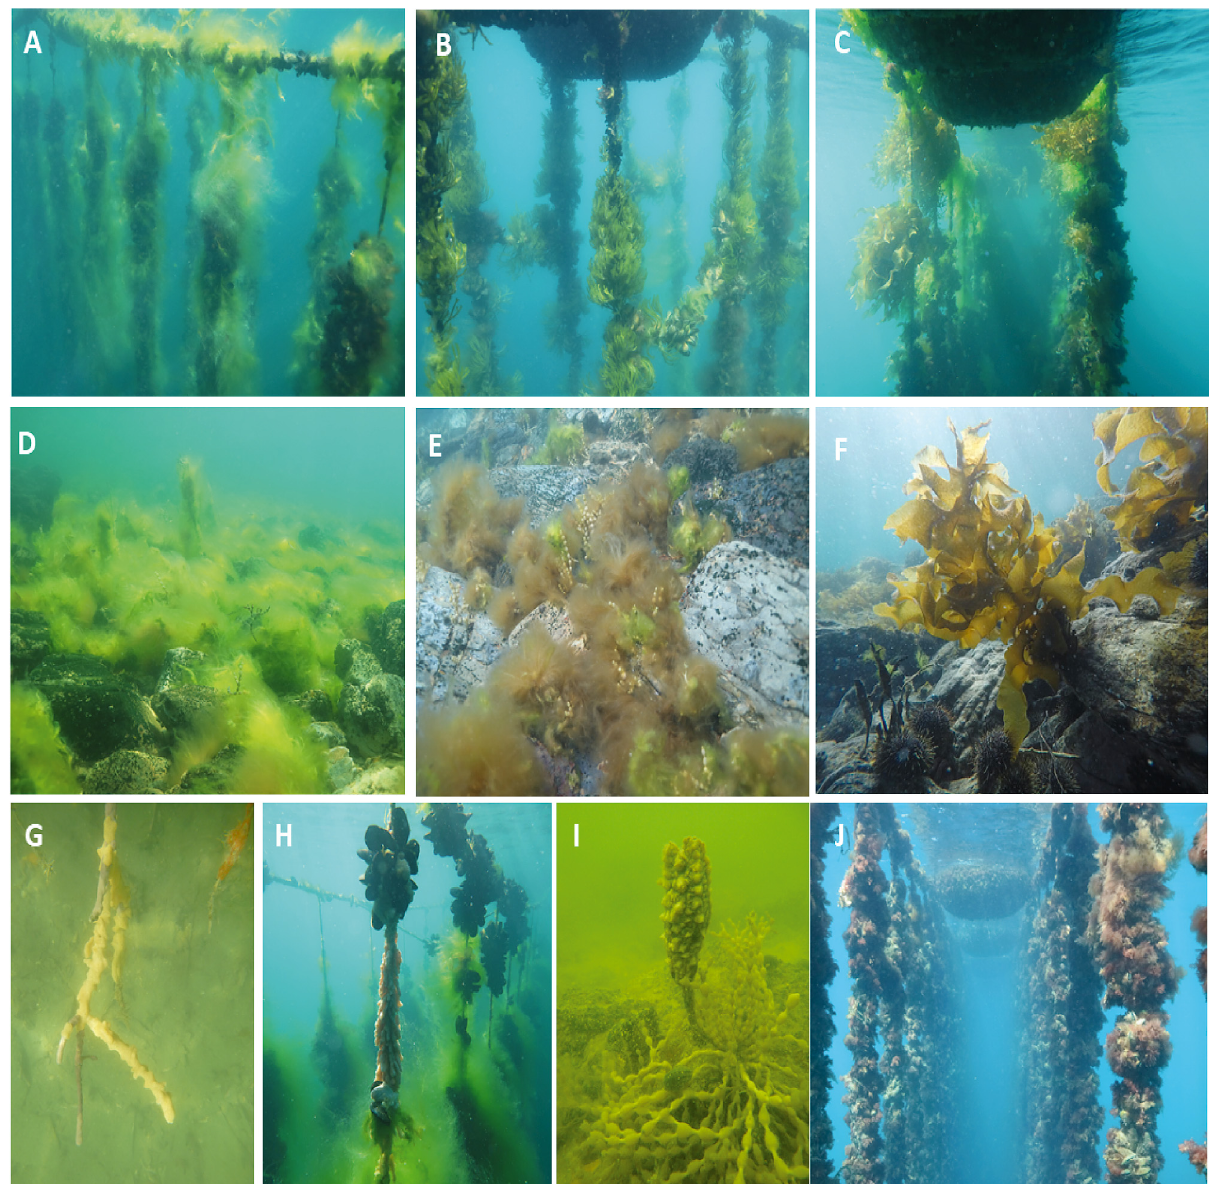
Fig. 2. Representative images of focal taxa growing (A,B,C,H,J) on farms and (D,E,F,G,I) in natural habitats, including (A,D,H) Cladophora ruchingeri , (B) Codium fragile , (C,F) Undaria pinnatifida , (E) Pylaiella littoralis, (G,H) Didemnum vexillum , (H) Mytilus galloprovincialis , (I) Styela clava , and (J)